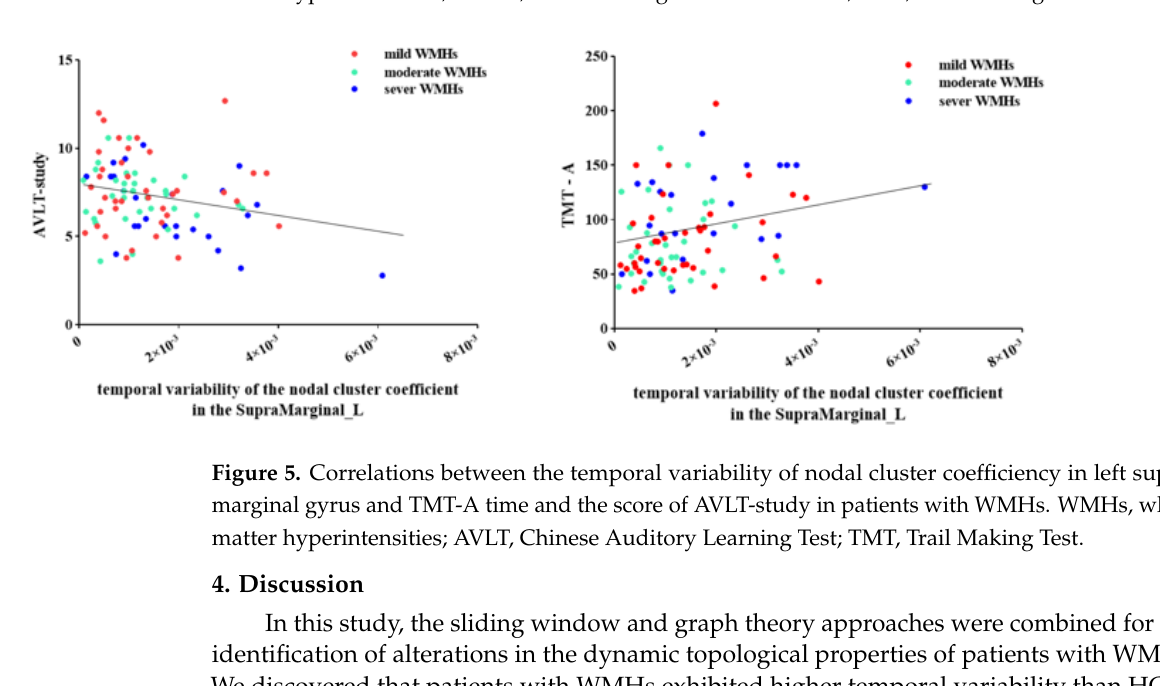
Figure 4. Correlations between the temporal variability of nodal efficiency in the left rolandic operculum and MoCA score, TMT-A time, and TMT-B time in patients with WMHs. WMHs, white matter hyperintensities; MoCA, Montreal Cognitive Assessment; TMT, Trail Making Test.